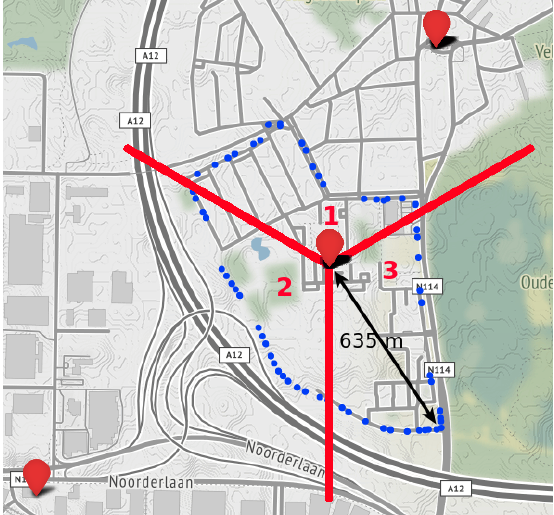
Figure 3. Map of the measurement campaign around a single eNB with three cell sectors, used to study the mobility. The 95 blue circles represent the GPS locations of each uplink transmission. The sector boundaries of each cell of the eNB are shown in